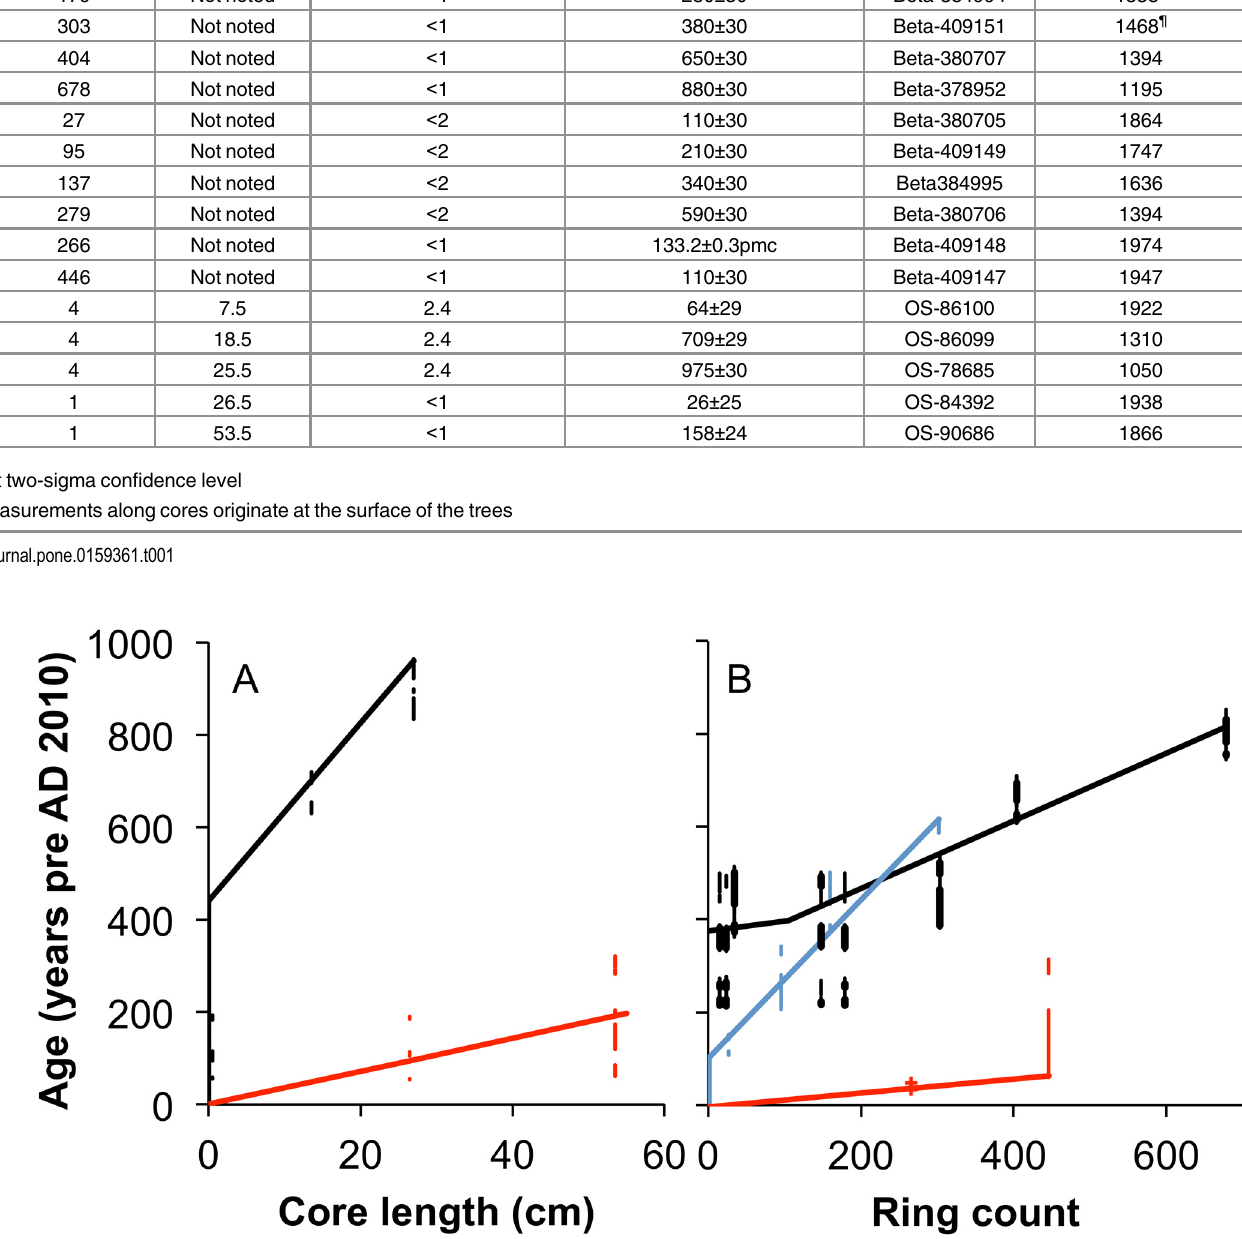
Fig 2. Age models for the baobabs. (A) Age models for the Schroda (red) and Luna (black) baobabs are based on incremental subsamples along the core. (B) The unit of analysis for the LKA (black), LKB (blue) and MPC (red) baobabs was rings. Vertical lines represent the one sigma AMS radiocarbon calibration ranges except for LKA where the two sigma range is represented, with the one sigma range represented as bold vertical lines. Crosses represent bomb-carbon AMS